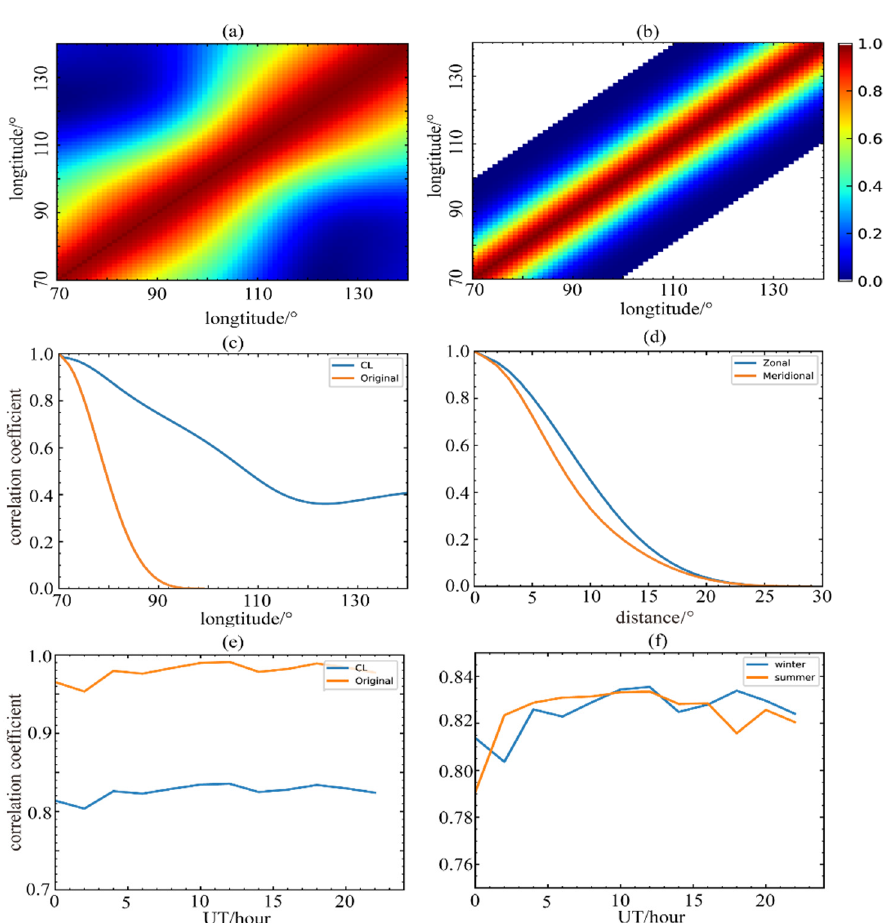
Figure 2. ( a ) The distribution of meridional correlation coefficients at 70°E, 15°N obtained from statistics; ( b ) the distribution of meridional correlation coefficients at 70°E, 15°N, localized by covariance; ( c ) the correlation coefficient curves of longitude before and after localization; ( d ) the correlation coefficient curves of zonal and meridional; ( e ) the change curves of the correlation coefficient before and after localization at 5° from the reference point; ( f ) the change curves of the correlation coefficient in different seasons at 5° from the reference point.